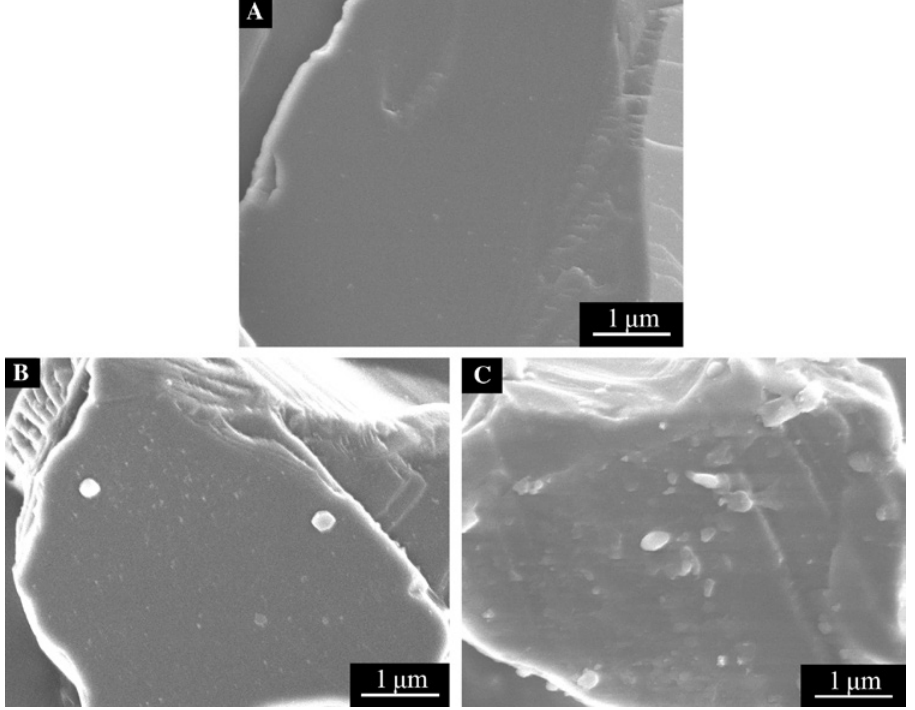
Figure 4: FE-SEM photographs of (A) pristine diamond, (B) KH550 modified diamond in aqueous alcohol, (C) KH550 modified diamond in toluene.